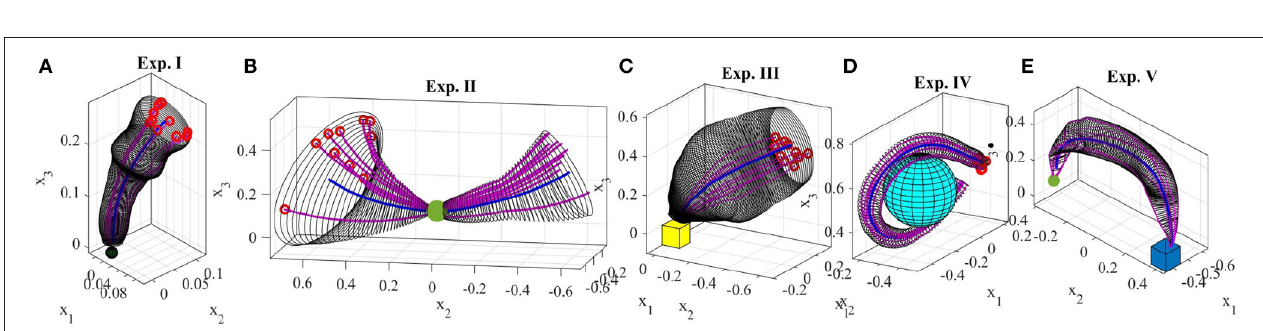
FIGURE 9 | Ten reproductions of the skill for each experiment. The reproduced trajectories (magenta) are generated using the fixed-ratio rule from arbitrary initial